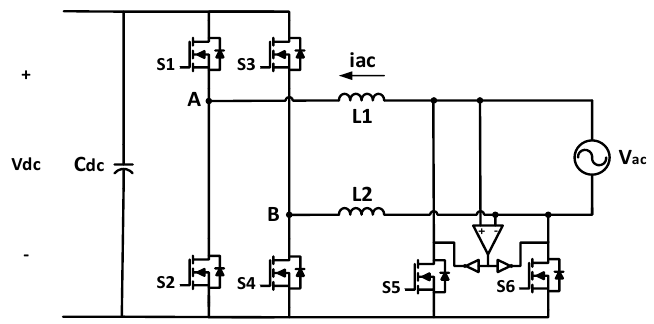
Figure 8. H4 bidirectional inverter full-bridge topology with additional paths [43].